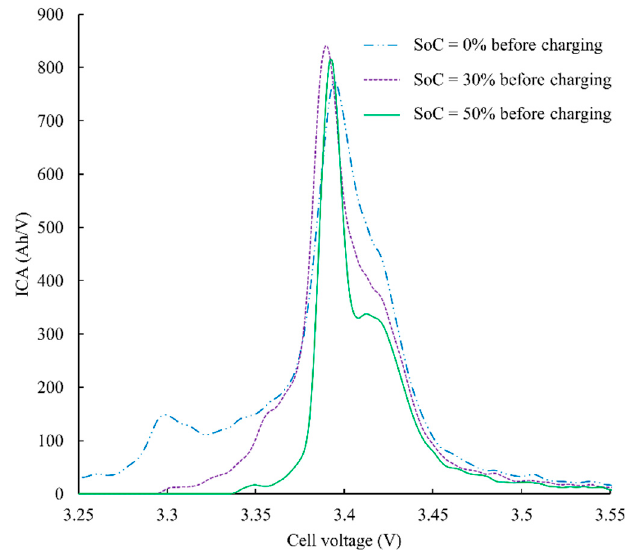
Figure 6. IC curves deformation function of the DoD (C/3-25 °C-SoH 80%).